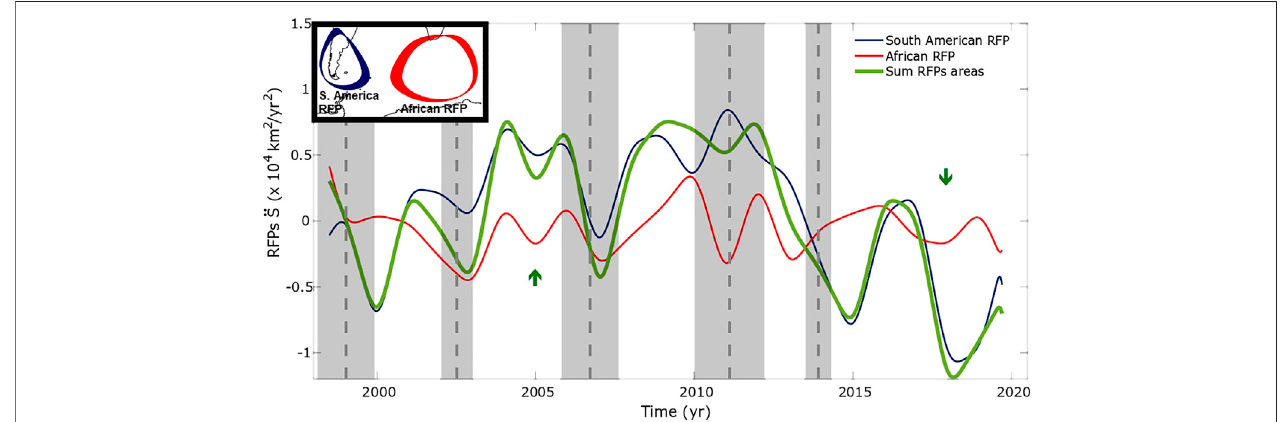
FIGURE3 | Secular accelerationof theareal extent ofthe RFPs at theCMB. Time evolution of thesecond derivative of theareal extent ofthe South American (blue line)andAfrican(redline)RFPsand(greenline)thesumofbotharealextentsattheCMB.Thearealextentiscalculatedastheareawithinthecontourlineof − 32,000 nTof Br (shown in the map in the fi gure) using CHAOS-7.2 model until degree 6, monthly from 1998.0 to 2020.2. In dashed vertical gray lines, the mean occurrence times of the well-de fi ned geomagnetic jerks for the last 2 decades are marked. Shaded bands mark the uncertainty of the occurrence times given by one standard deviation. With green arrows other interesting features are indicated (see Discussion in the main text for more